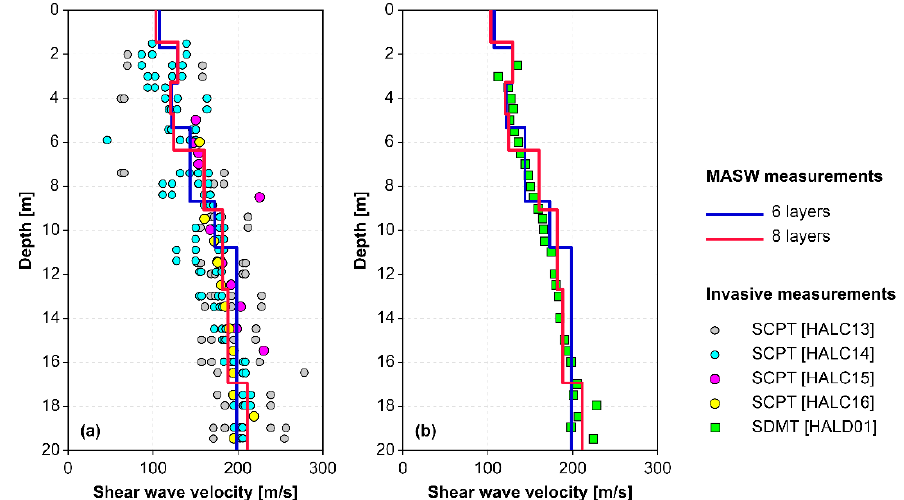
Figure 21. Comparison of inverted V S -profiles (six- and eight-layer parameterizations) and results of ( a ) Seismic Cone Penetration Tests (SCPT) and ( b ) Seismic Dilatometer Marchetti Tests (SDMT) conducted in close proximity to the MASW profile.